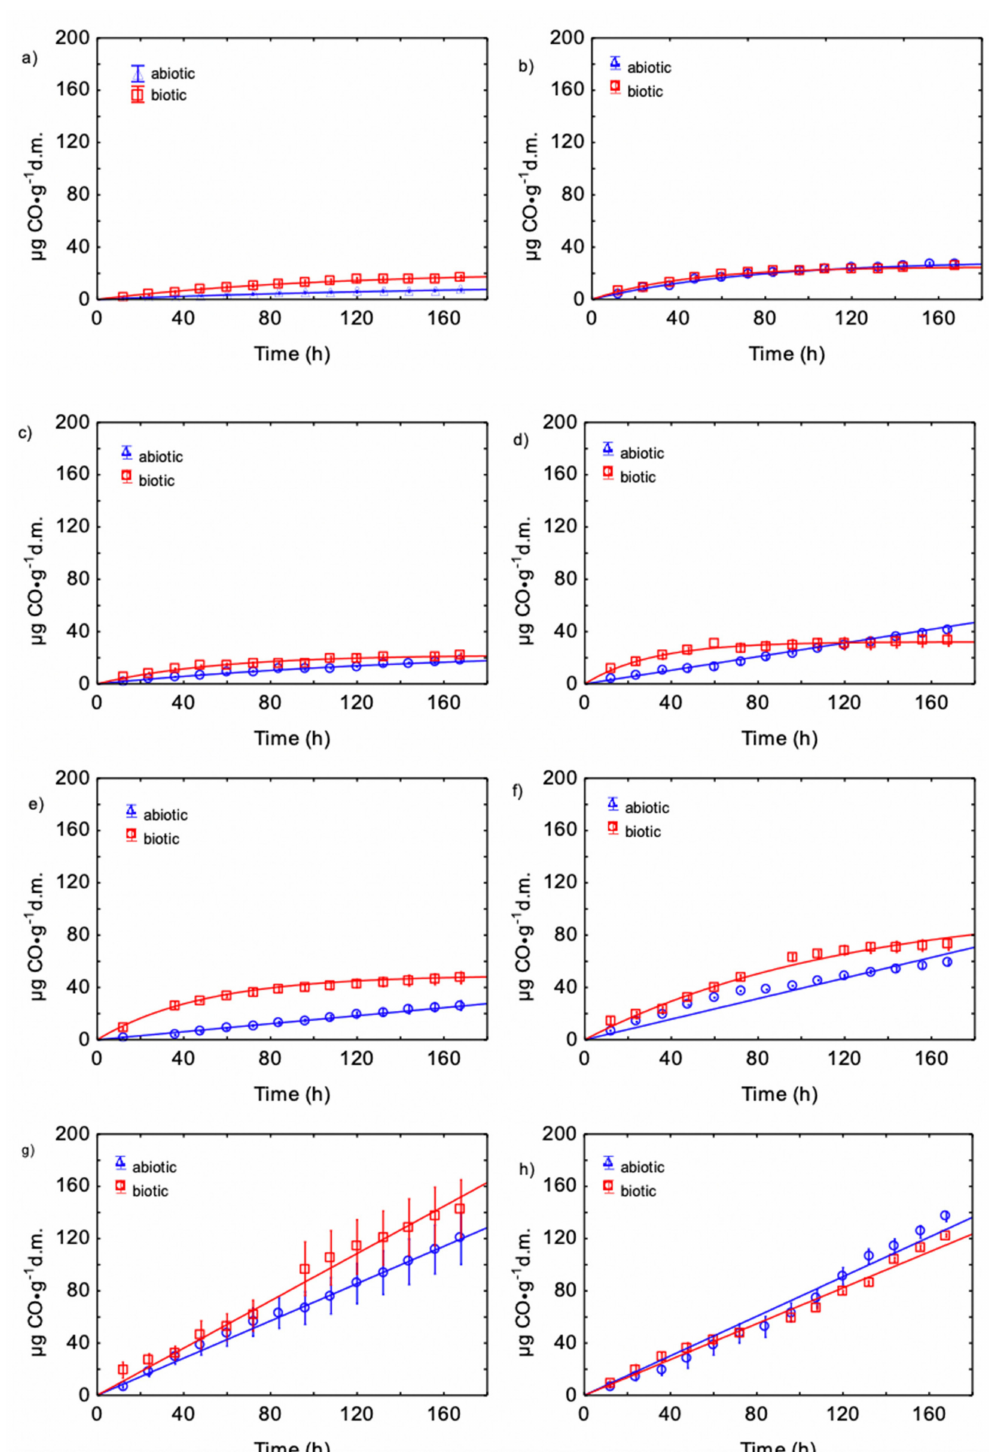
Figure 6. Cumulative CO production depending on the temperature under abiotic and biotic conditions under di ff erent fixed temperatures ( a ) 10 ◦ C, ( b ) 20 ◦ C, ( c ) 30 ◦ C, ( d ) 37 ◦ C, ( e ) 40 ◦ C, ( f ) 50 ◦ C, ( g ) 60 ◦ C, ( h ) 70 ◦ C. The error bars are showing +/ − standard deviation around the mean. Raw data are shown in Tables S1.5 and S1.51 (Supplementary Materials, sheet 3). The kinetic values are shown in Table S2.3 (Supplementary Materials, sheet 6). Equations used in figures are shown in Table A1. The Tukey test p < 0.05 are shown in Tables S3.57–S3.84 (Supplementary Materials, sheet